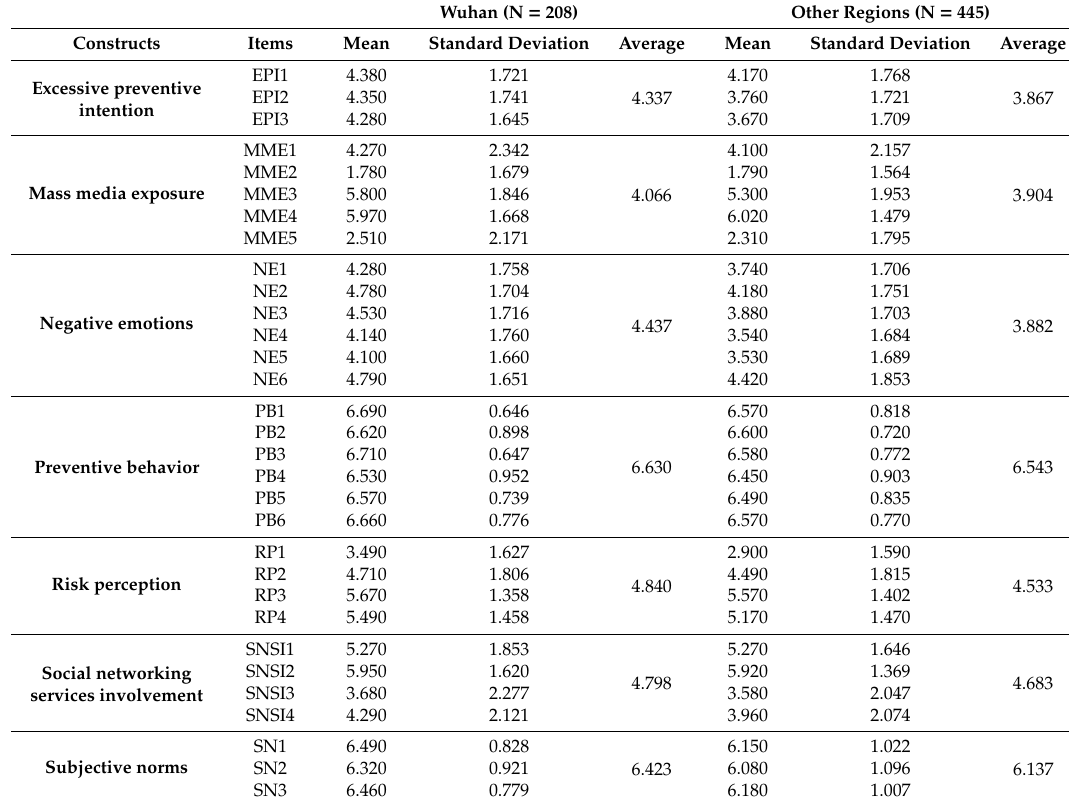
Table 2. Descriptive statistics of the variables in the